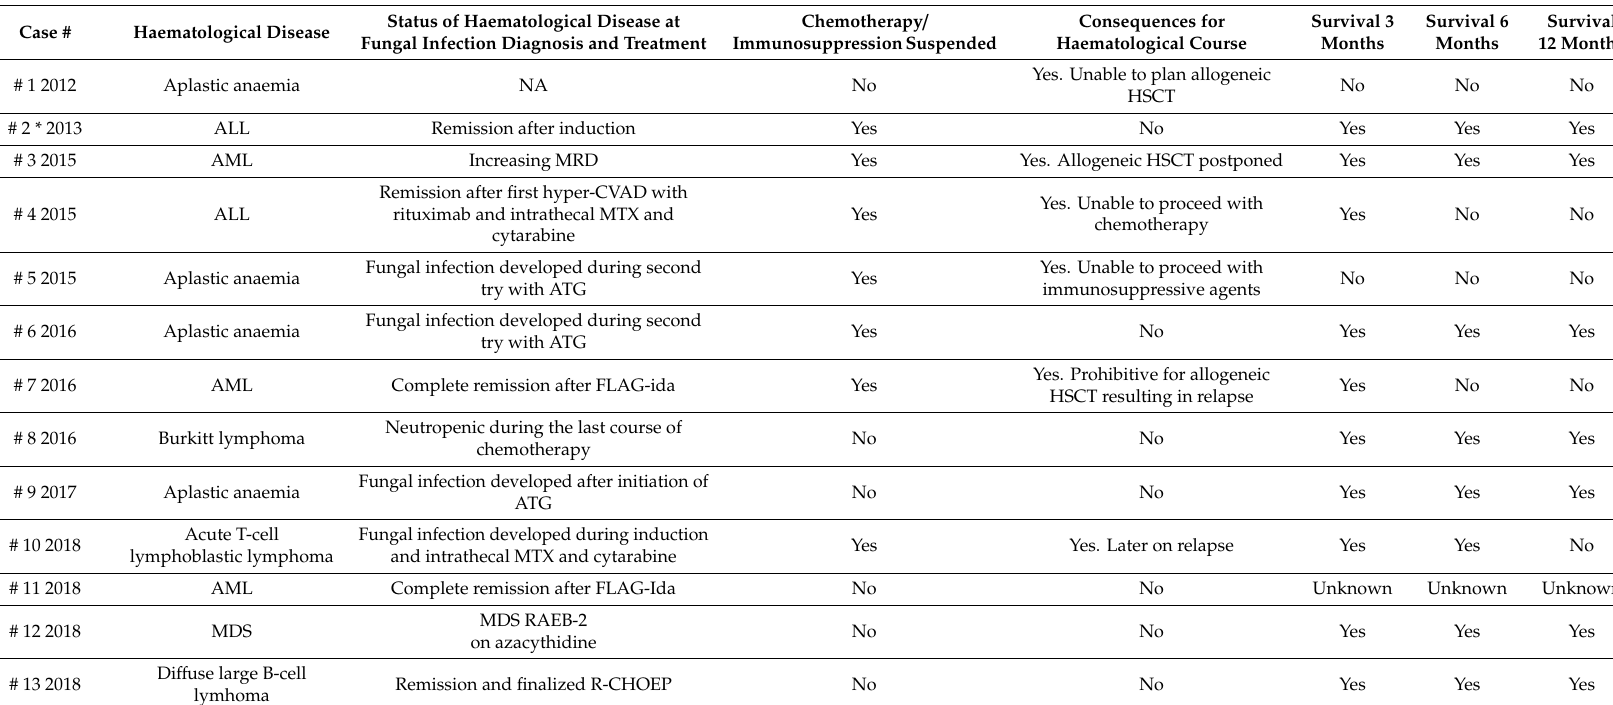
Table 5. Haematological status and